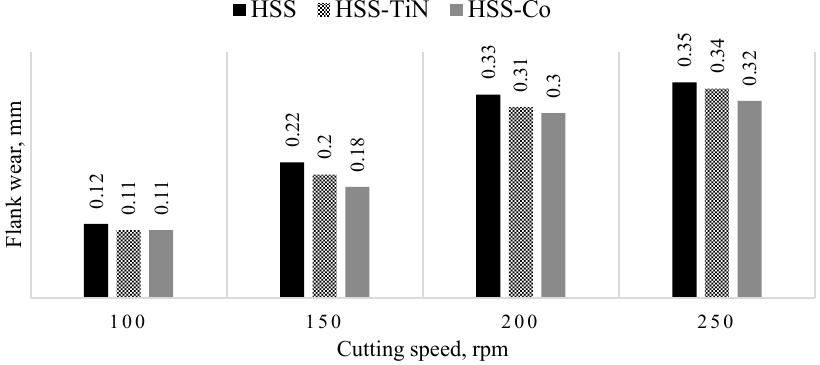
Figure 6. Flank wear value of cutting tools 25th hole at different spindle speeds.